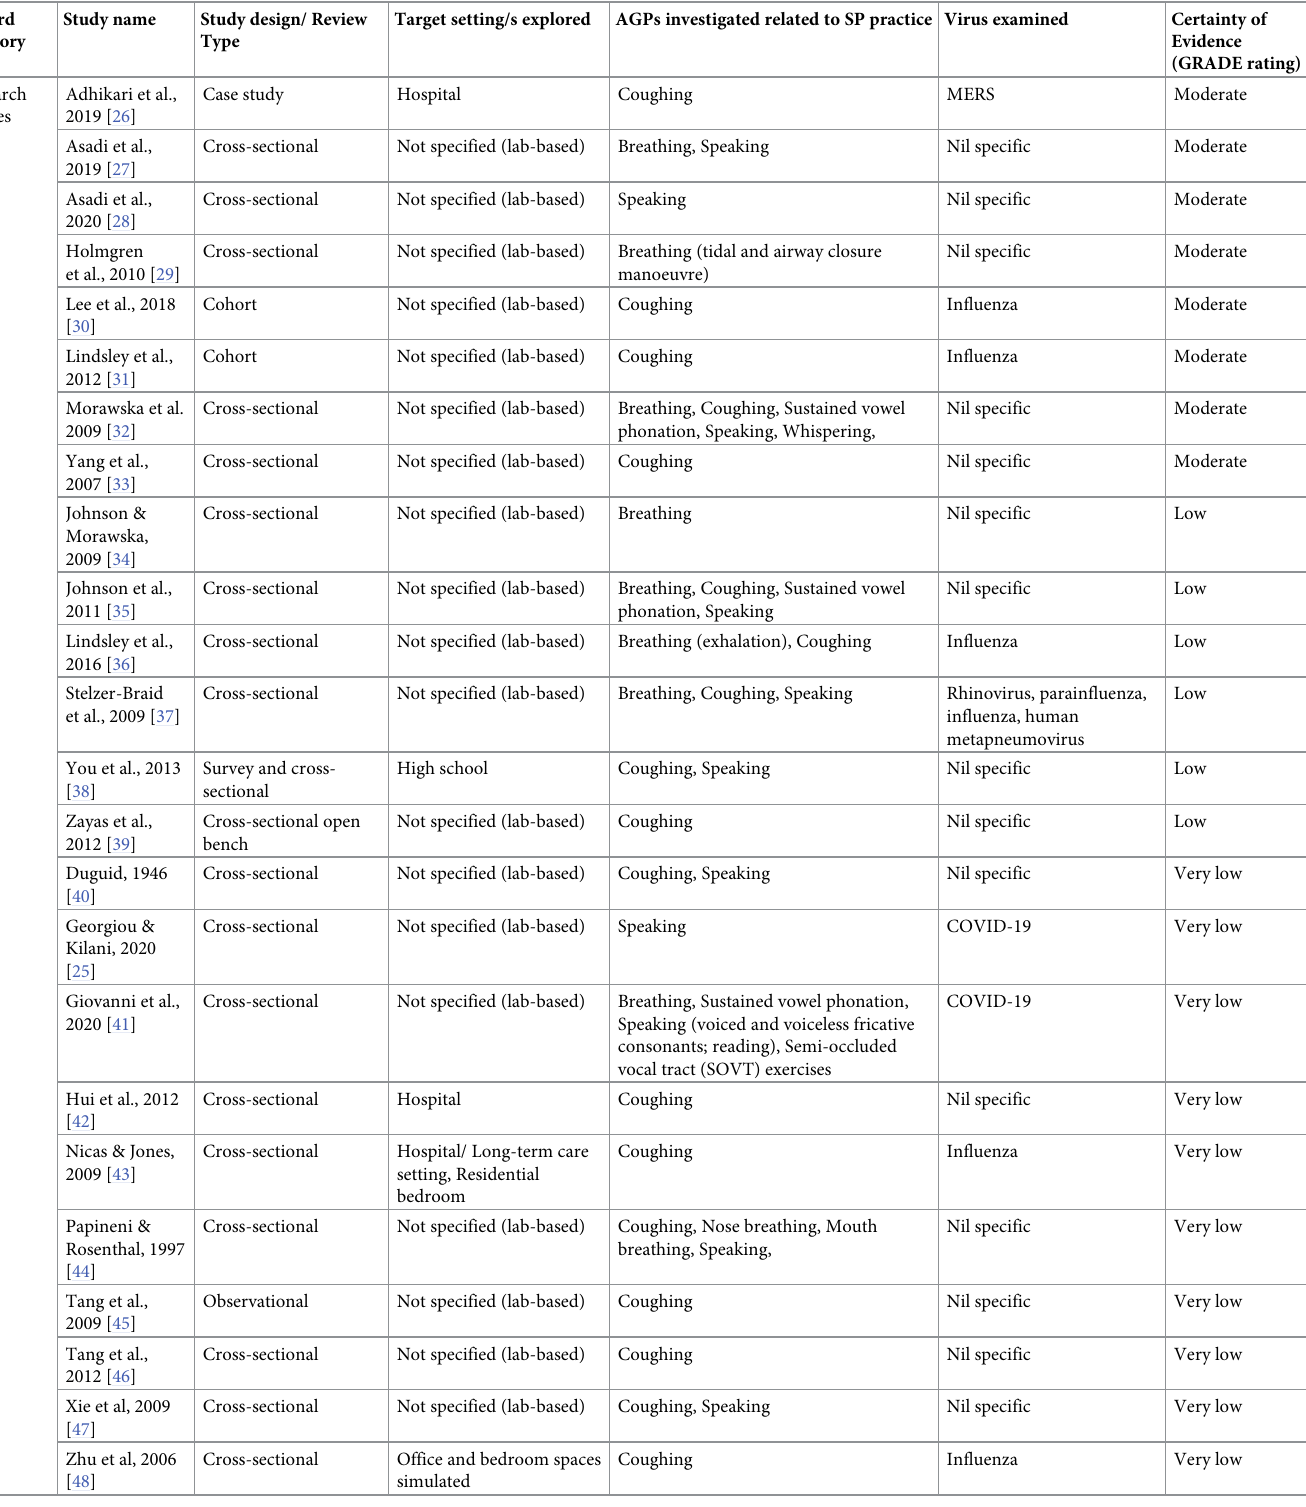
Table 1. Summary of characteristics of included